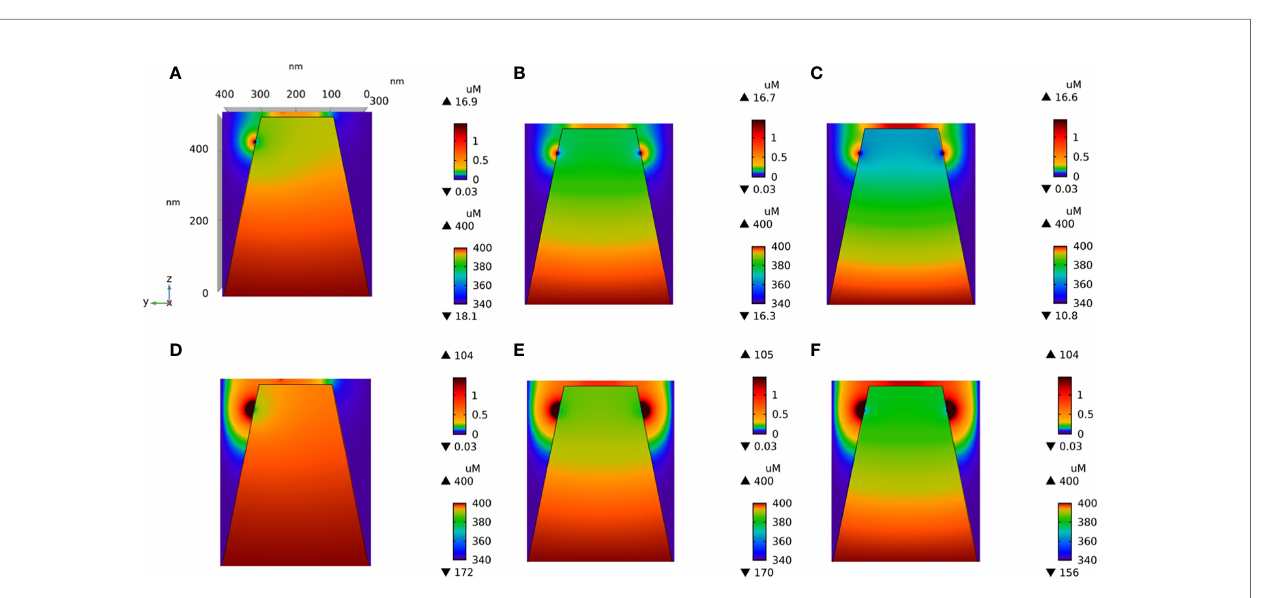
FIGURE 7 | Cross-section of the Ca 2+ pro fi les in the junction, in the cytosol adjacent to the junction and in the sub-PM ER during microdomain for two values of the Ca 2+ diffusion coef fi cient in the ER, D S . (A – C) : microdomains created by the opening of 2, 5 and 7 IP 3 Rs, respectively, for D S = 10 m m 2 /s. Local depletion of ER Ca 2+ provokes the opening of the nearby ORAI1s. This situation corresponds to the one shown in Figure 3 . (D – F) : microdomains created by the opening of 2, 5 and 7 IP 3 Rs, respectively, for D S = 110 m m 2 /s. Local depletion of ER Ca 2+ provokes the opening of the nearby ORAI1s. This situation corresponds to the one shown in Figure 5 . For all panels, the upper right bar indicates the color code of Ca 2+ concentration in the cytosol while the lower right bar indicates the color code of Ca 2+ concentration in the